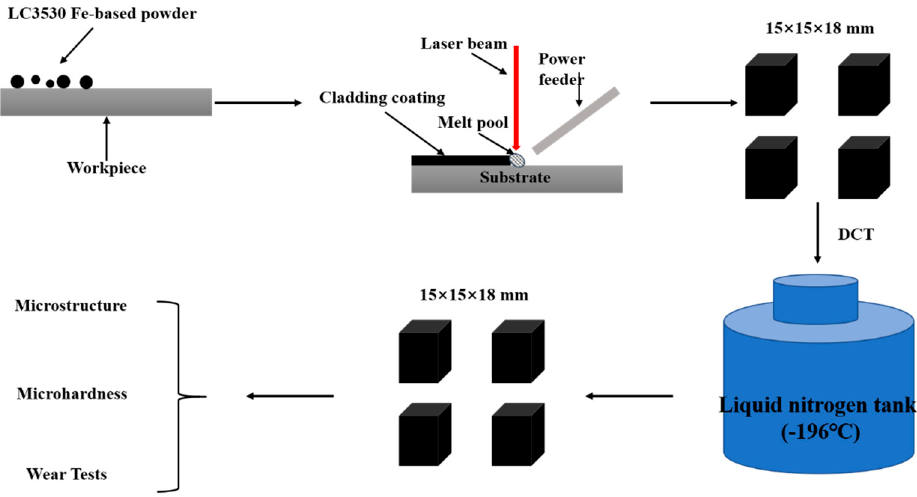
Figure 1. Experiment process profile.